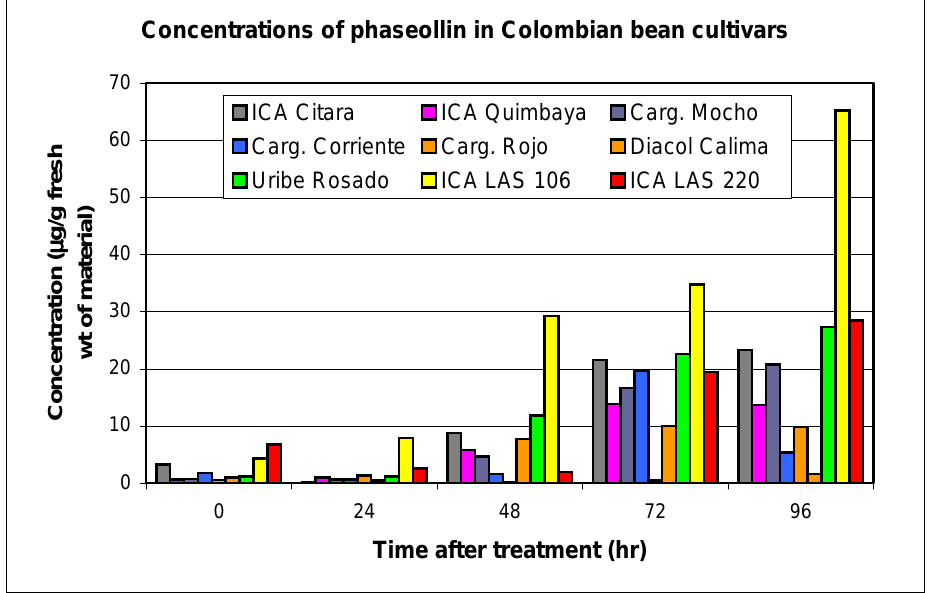
Concentrations of phaseollin in Colombian bean